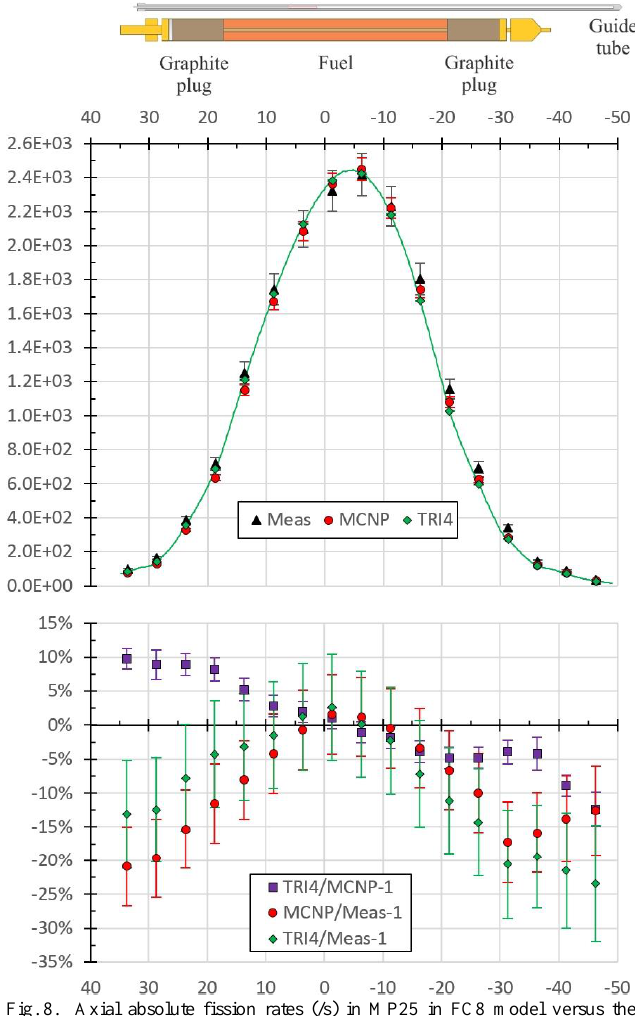
Fig. 8. Axial absolute fission rates (/s) in MP25 in FC8 model versus the altitude Z (cm) with a schematic of a standard fuel element at same